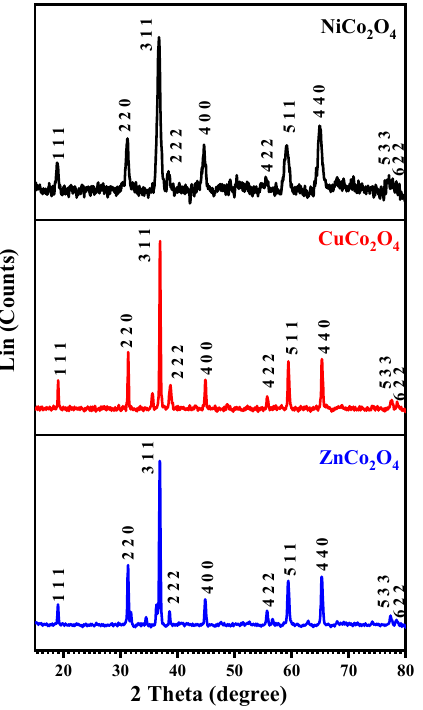
Figure 1. XRD patterns of synthesized NiCo 2 O 4 , CuCo 2 O 4 , and ZnCo 2 O 4 .